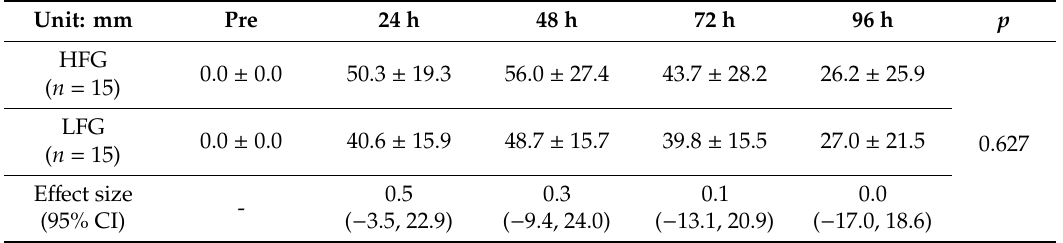
Table 4. Active muscle soreness following eccentric exercise according to %fat.